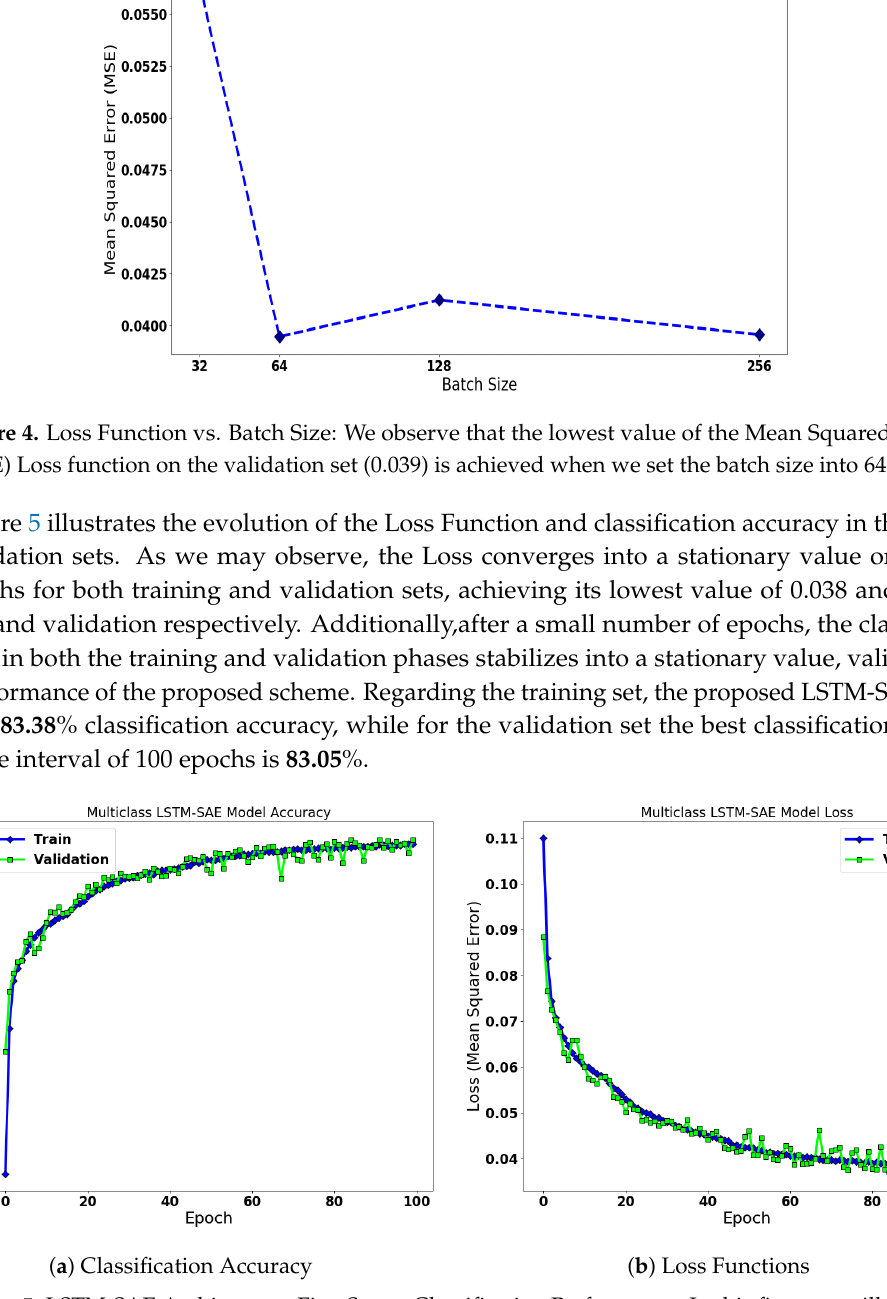
Figure 5. LSTM-SAE Architecture: Five-Status Classification Performance. In this figure, we illustrate the evolution of the Loss function (i.e., MSE), and the Classification Accuracy on Training and Validation sets. We observe, that after only few running iterations, the proposed LSTM-SAE architecture stabilizes into its fixed values for both training and testing sets, and for both evaluation